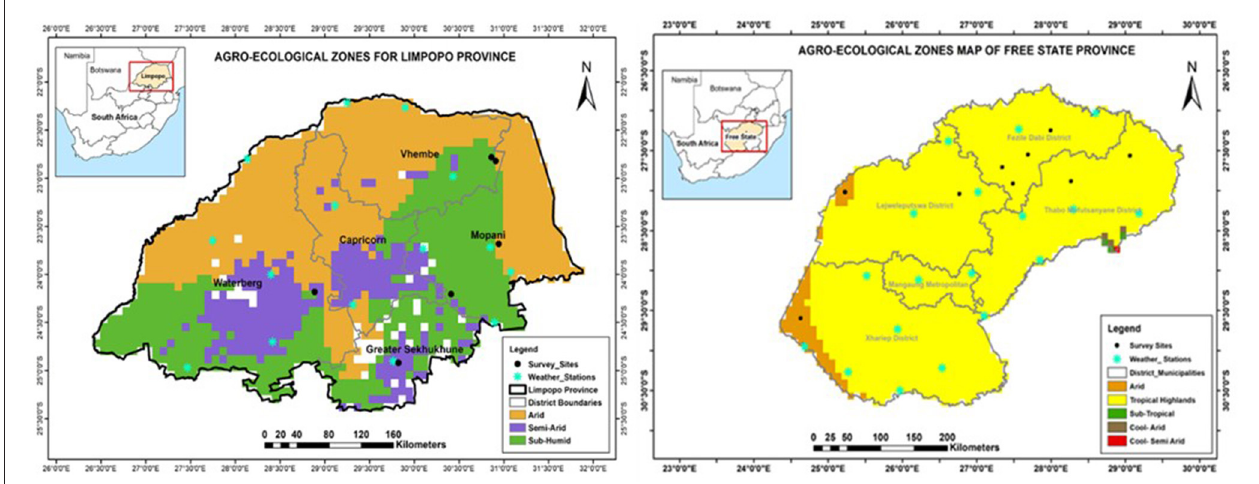
FIGURE 2 | Location map for Limpopo and the Free State Provinces with sampled sites. Source: Adapted from Harvest Choice (2010).